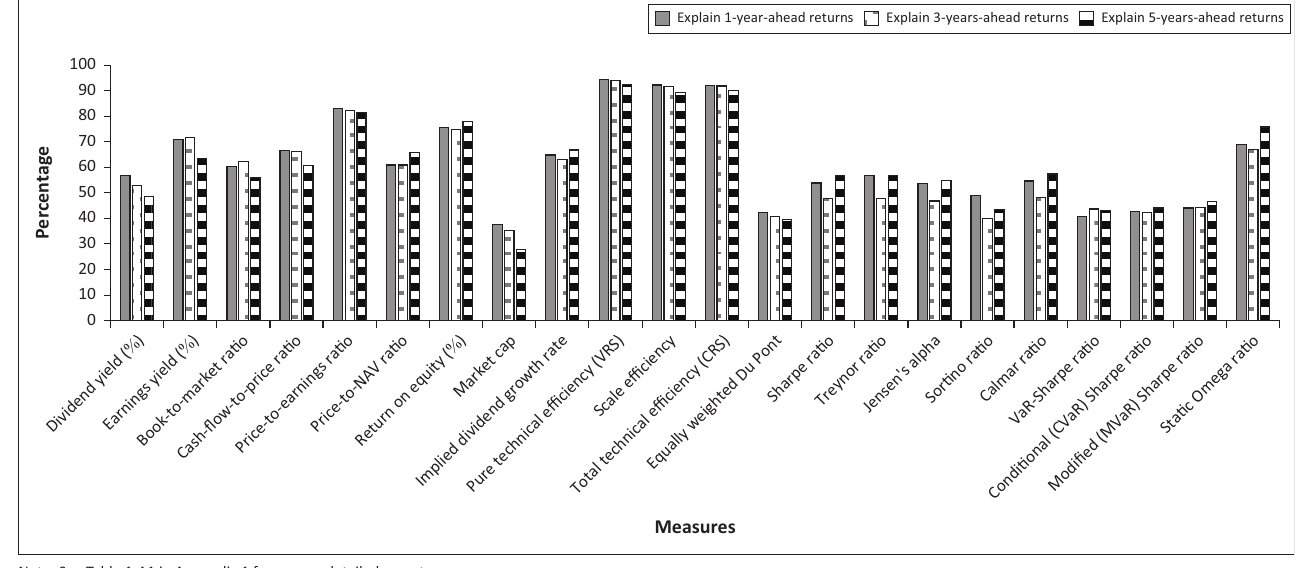
FIGURE 1: Average ability to explain future returns (across all